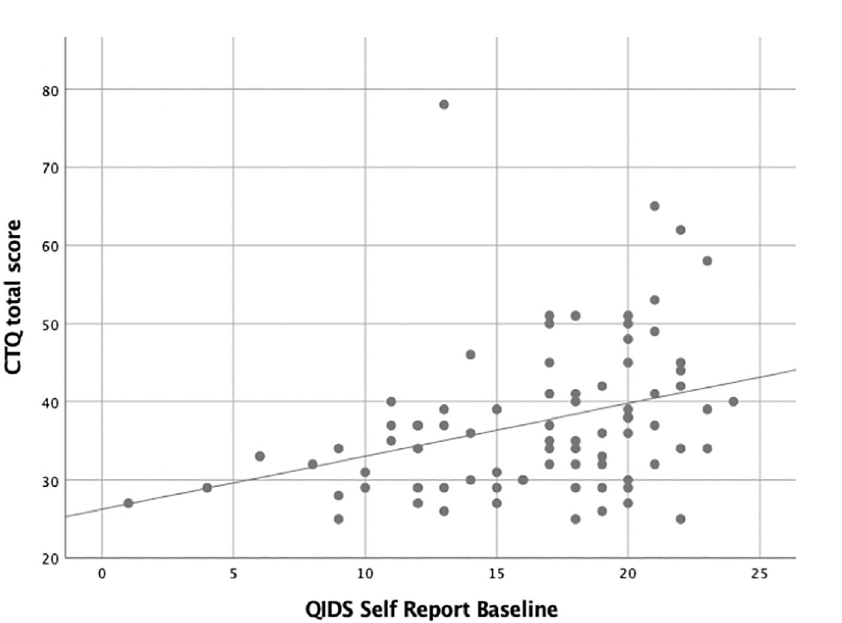
Fig 2. Association between Childhood trauma and intensity of self-reported depressive